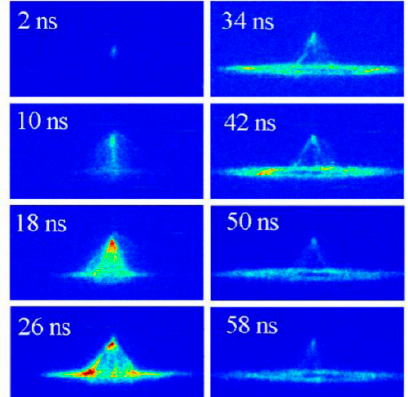
Figure 2. Images of discharge in air captured by an intensified charge-coupled device (ICCD) with an exposure time of 4 ns.